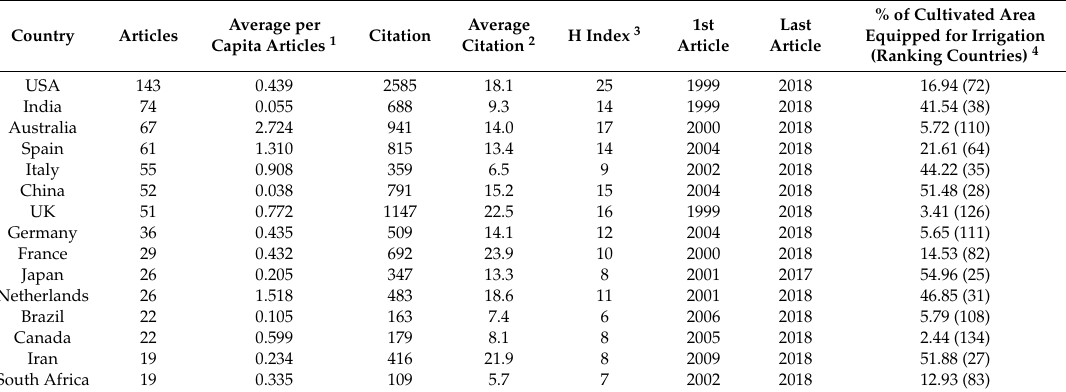
Table 3. Main characteristics of the most active countries related to SI